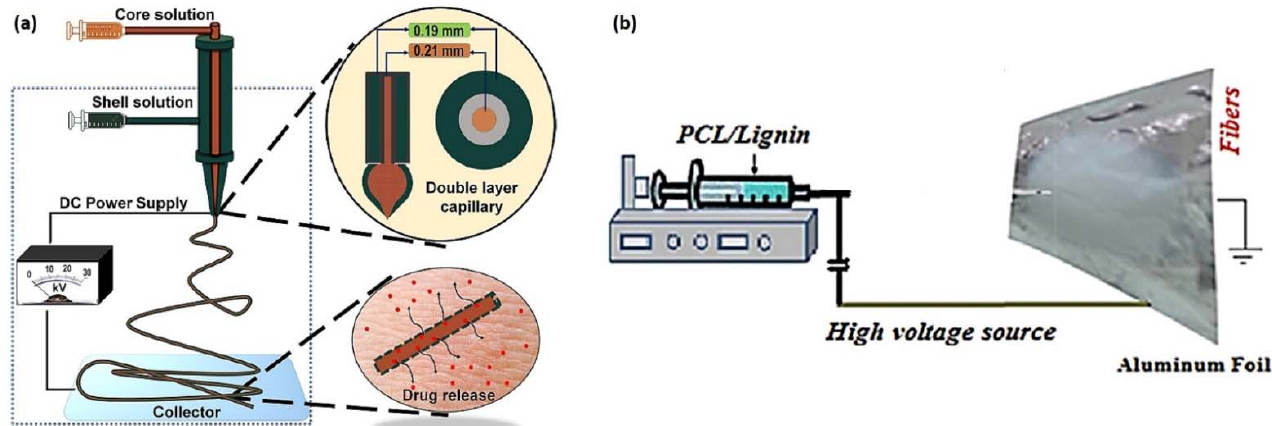
Figure 8. Examples of ( a ) the coaxial electrospinning of chitin–lignin-based hybrid fiber encapsula- tion by PCL (reproduced from Ref. [5] with permission from Springer Nature), and ( b ) the blend electrospinning of PCL–lignin nanocomposite scaffold (reproduced from Ref. [53] with permission from the PMC).